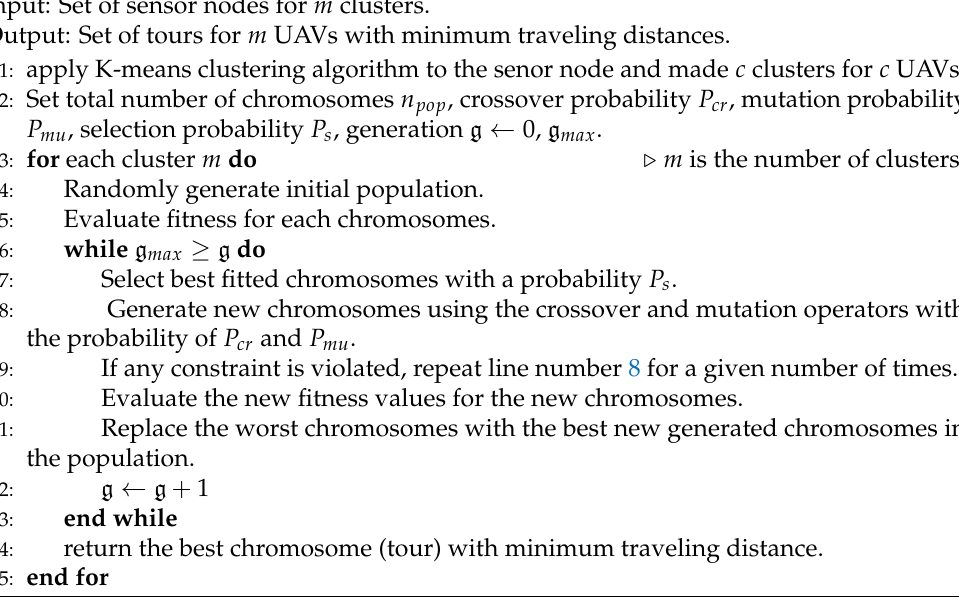
Algorithm 2 A genetic-algorithm-based path planning with VRAOA (GA w/VRAOA)